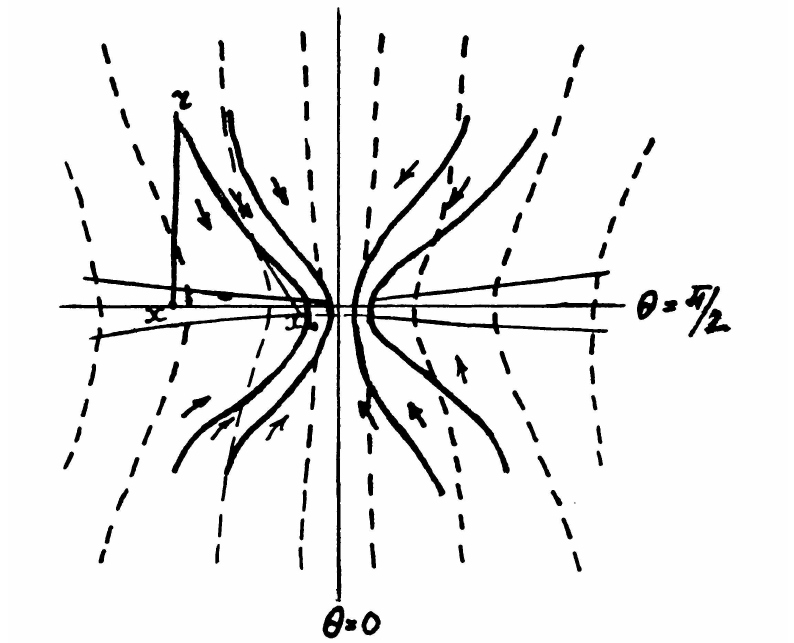
Figure 4. Schematic pattern of magnetic field lines in the matter around a BH for a field which is uniform at infinity, with the inclusion of distortions due to disk currents. The non-perturbed external magnetic field is shown by dashed lines. The solid lines determine the magnetic field lines, influenced by the azimuthal electrical currents in the disk. The domain of the disk influence is determined by the radius r ( x 0 ) , x ( x 0 ) , where field perturbations from the disk are small. The arrows indicate a direction of a gas flux velocity, with account of perturbations from the disk, from Reference